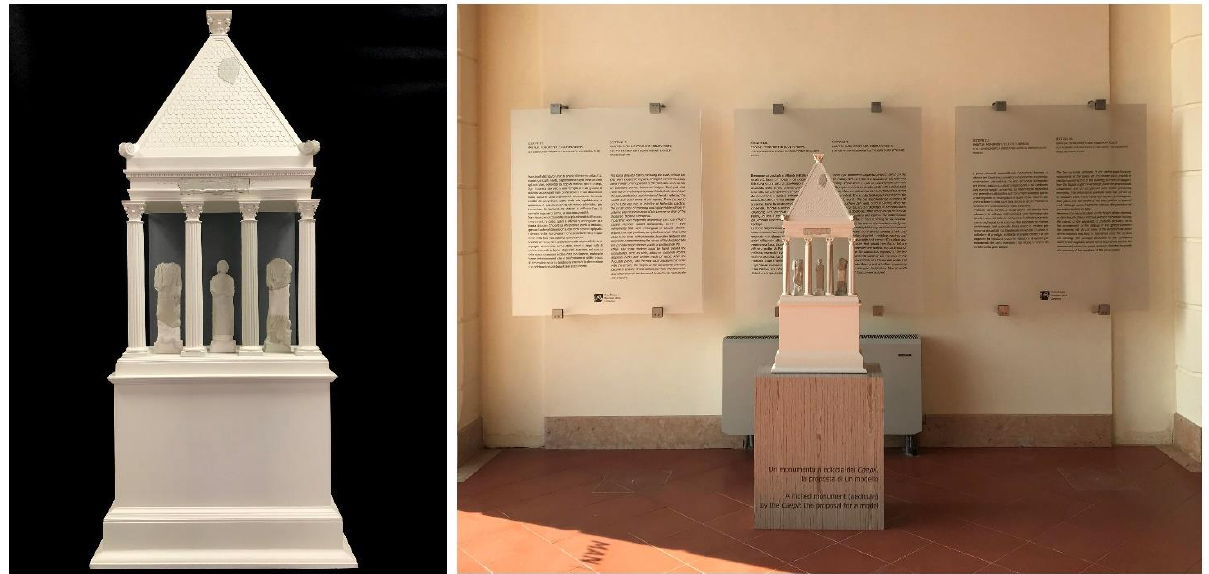
Figure 5: Details of the model and installation at the Museo Archeologico Nazionale di